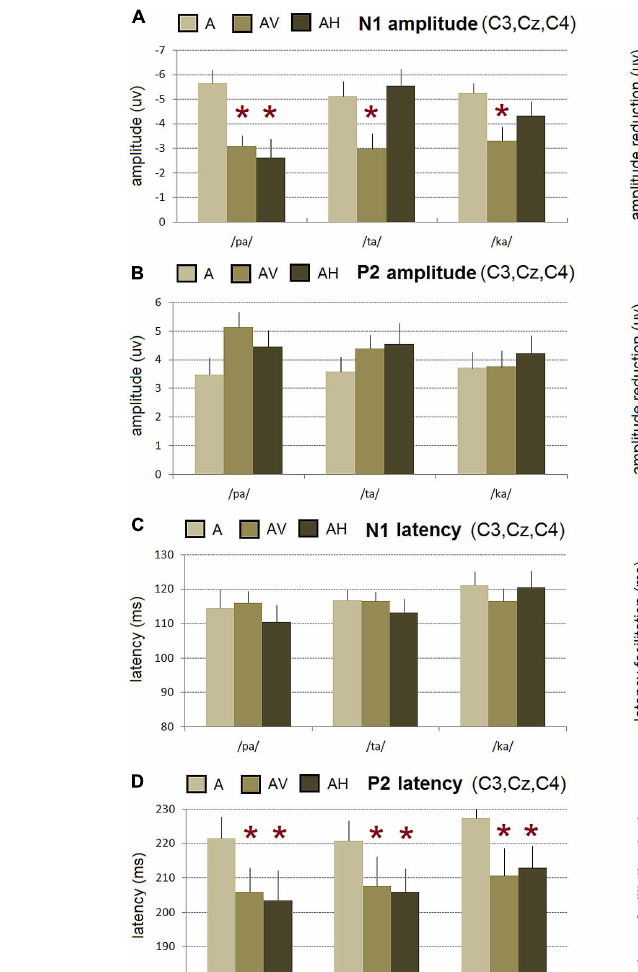
Right . Correlation on raw data between the recognition scores observed in the visual-only and haptic-only modalities in the behavioral experiment ( x -axis) and the reduction amplitude and latency facilitation observed in the audio-visual and audio-haptic modalities in the EEG experiment ( y -axis). No correlation was